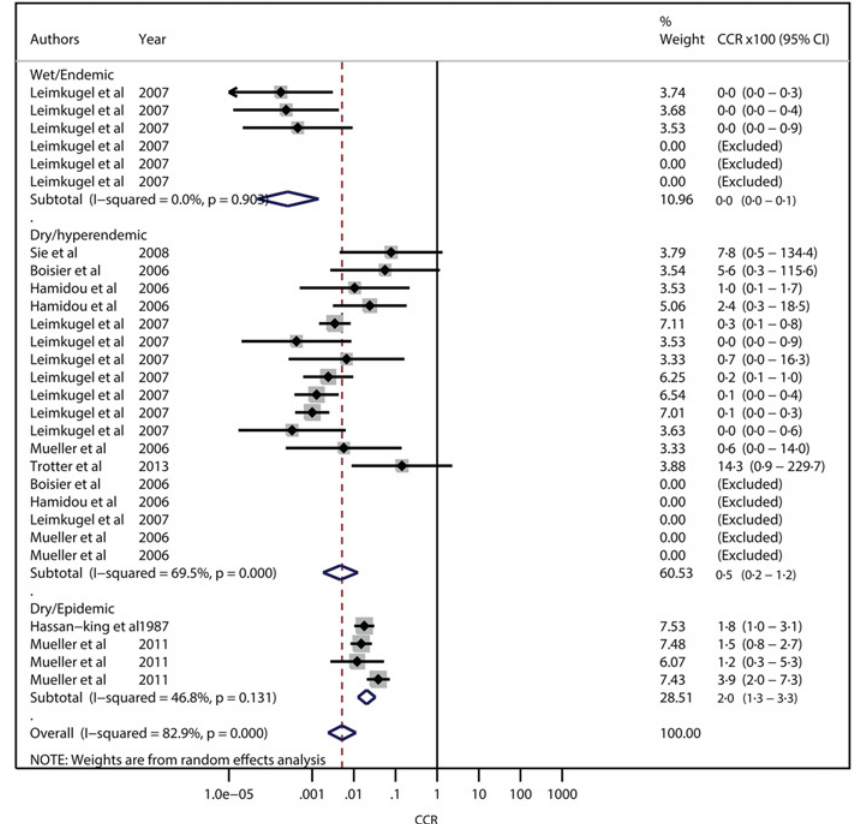
Figure 4. Forest plot for meta-analysis of serogroup A meningococcal meningitis case-carrier ratios according to epidemiological context in the African meningitis belt.